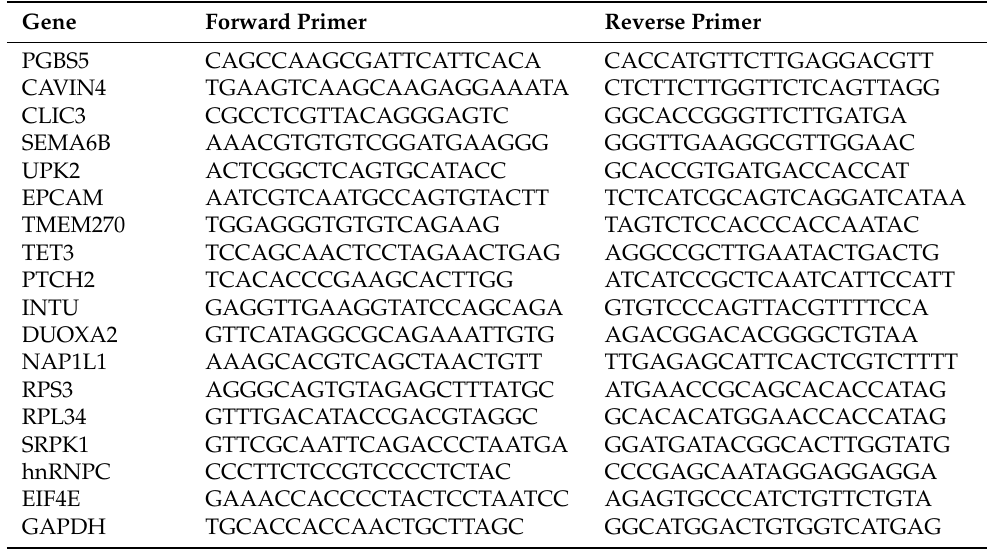
Table 1. List of the primer sequences used for RT-PCR